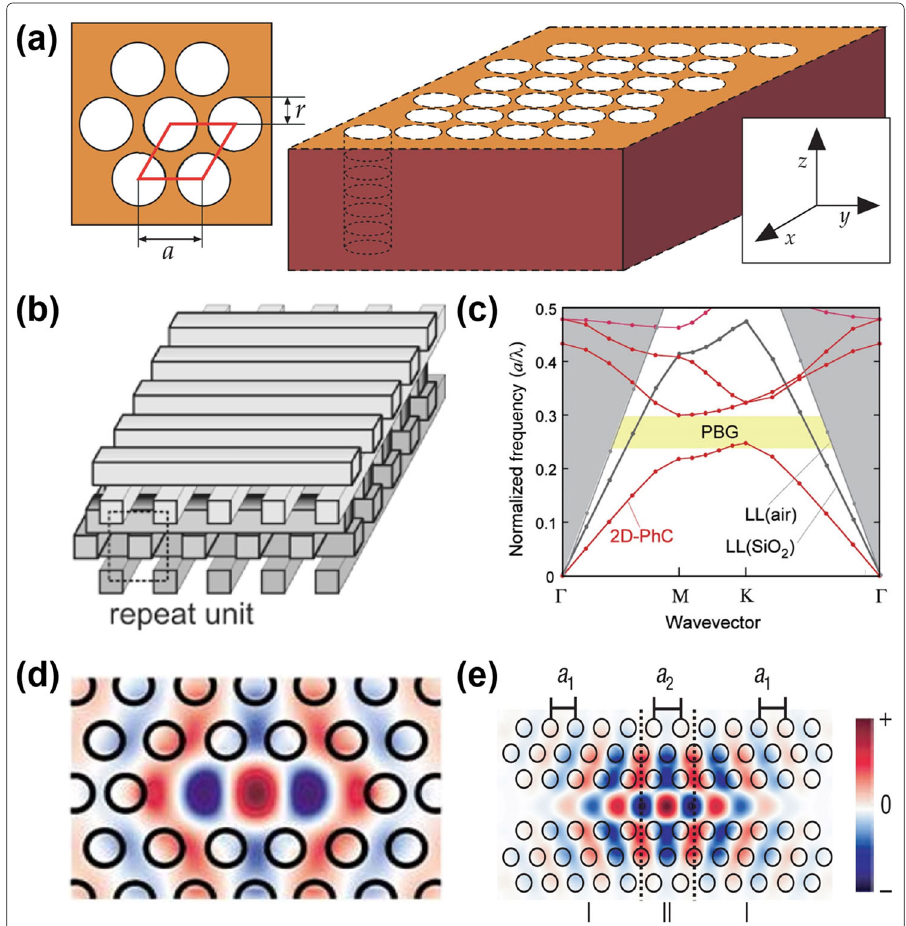
Fig. 4 The basic concepts of PCs. a A schematic diagram of a 2D PC slab [102]. b A schematic diagram of 3D PC [103]. c A photonic band diagram of a 2D PC slab [104]. d The electric field in a L3 cavity by shifting